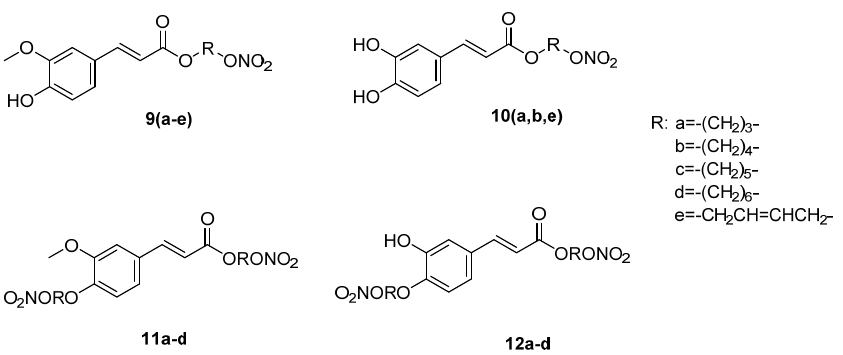
Figure 4. Chemical structure of the nitrooxy esters of cinnamic acid s 9–12 with anti-atherosclerotic and anticancer activities [36,37]. and anticancer activities